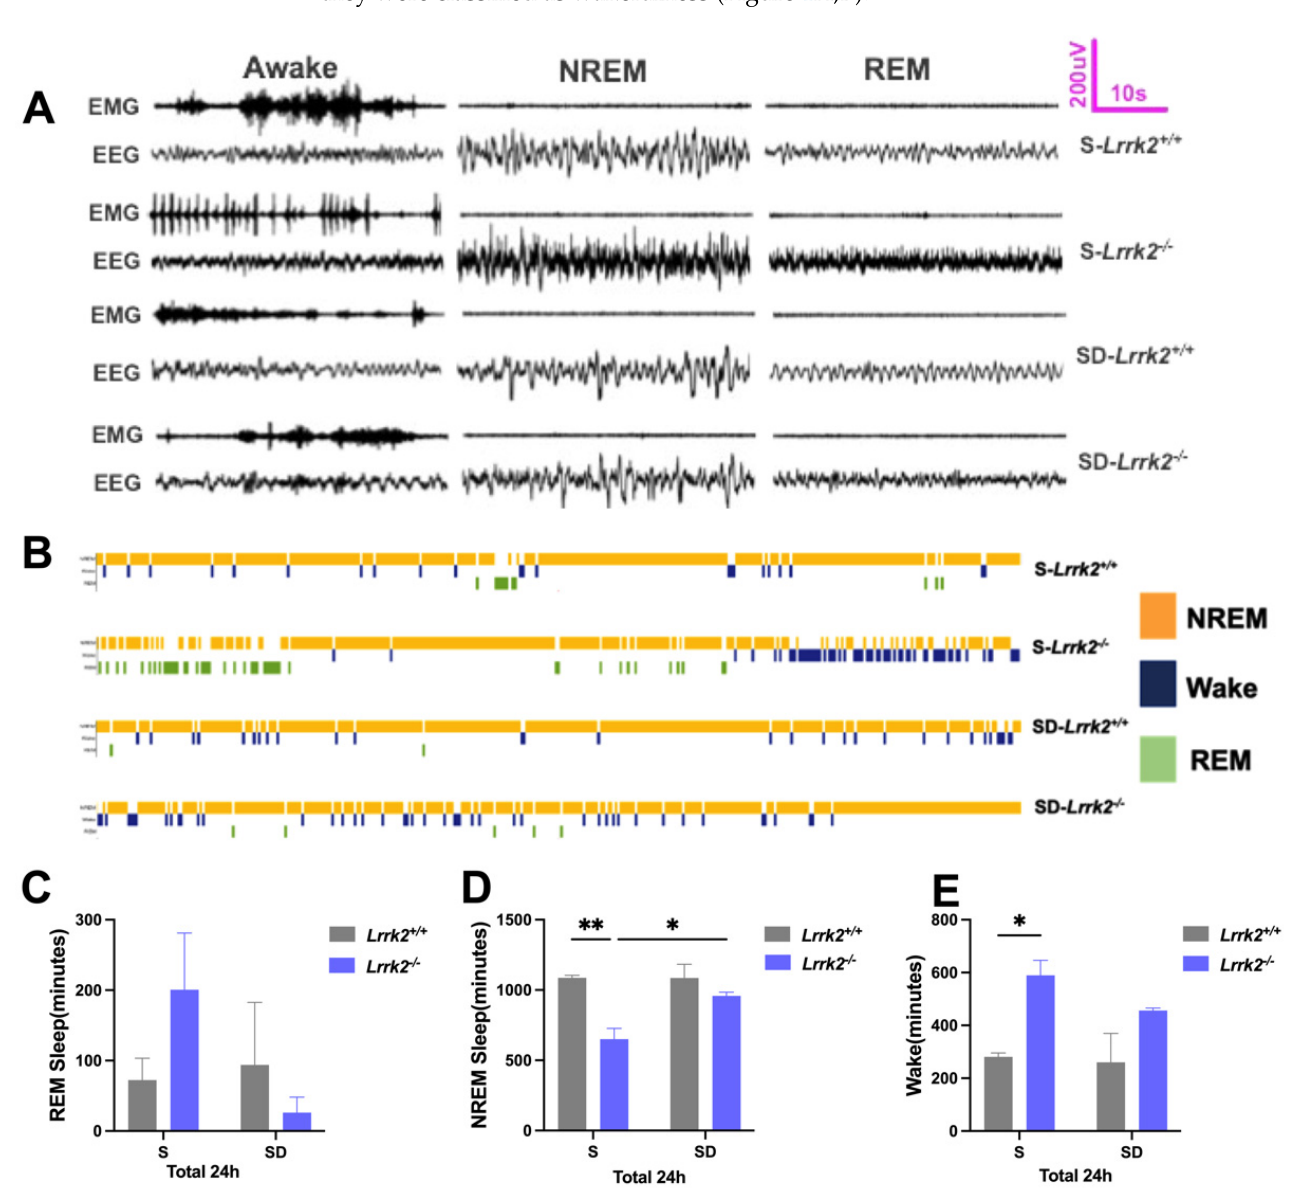
Figure 1. The inverted effects of LRRK2 deficiency on the NREM sleep before and after SD. ( A ) Representative EEG and EMG traces recorded from the S- Lrrk2 +/+ , S- Lrrk2 -/- , SD- Lrrk2 +/+ , and SD- Lrrk2 -/- groups during the REM sleep, NREM sleep, and wakefulness. ( B ) Channel assignments corresponding to color coding (wakefulness, blue; NREM sleep, yellow; REM sleep, green). Individual hypnograms for S- Lrrk2 +/+ , S- Lrrk2 -/- , SD- Lrrk2 +/+ and SD- Lrrk2 -/- groups under undisturbed